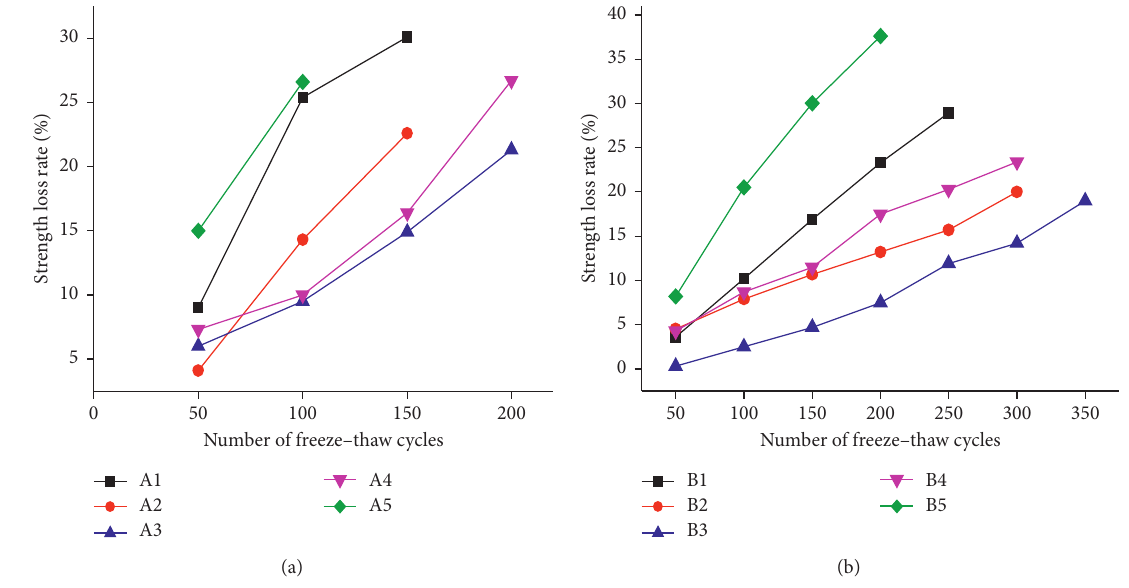
Figure 7: Strength loss rate of concrete after different freeze-thaw cycles. (a) C30. (b)